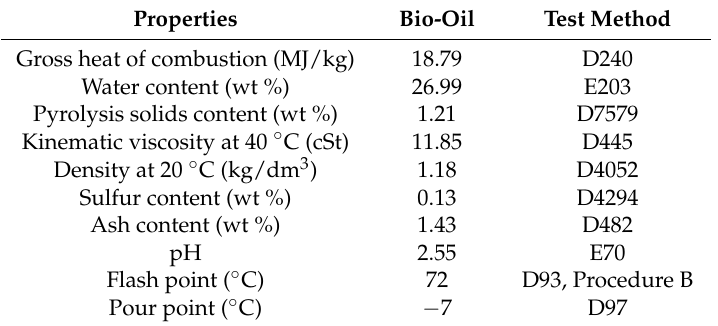
Table 2. Physicochemical properties of the bio-oil based on the test methods of ASTM D7544.